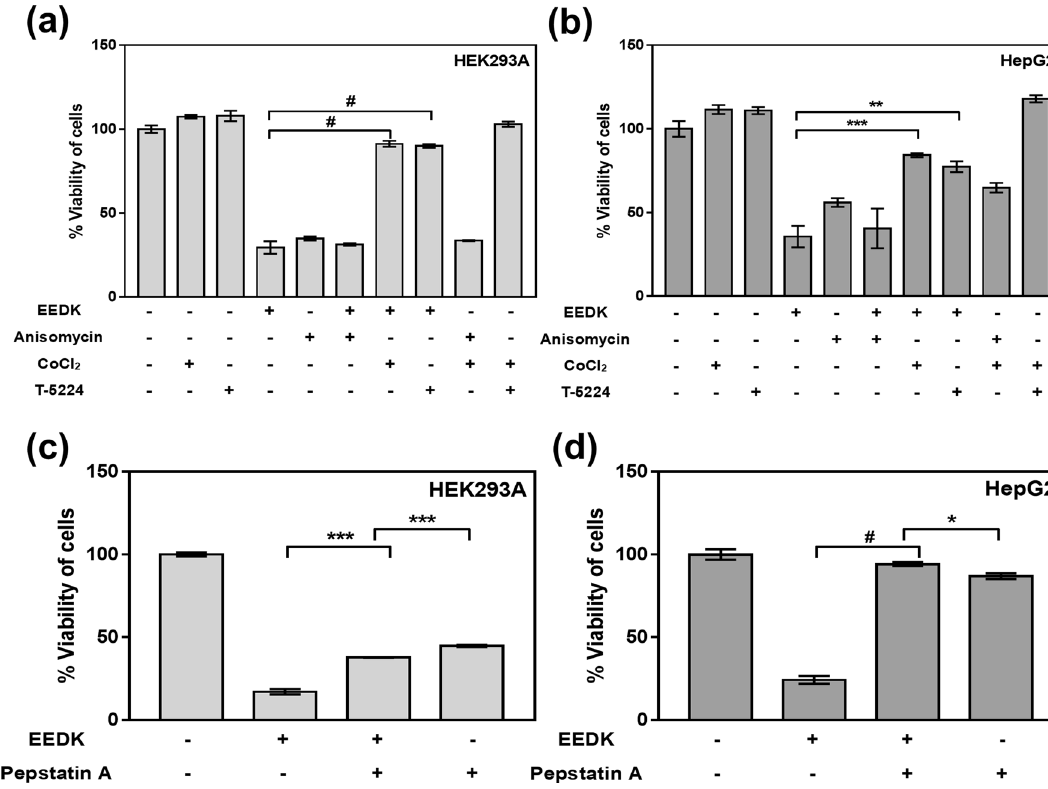
Figure 7. The effects of EEDK on cell death are dependent on JNK-AP-1/p53 activity. ( a , b ) Viability of ( a ) HEK293A and ( b ) HepG2 cells treated with or without the control (0.5% (v/v) DMSO), EEDK (100 μg/mL), anisomycin (JNK activator, 4 μM), CoCl 2 (hypoxia mimicking agent, 150 μM), and T-5224 (AP-1 inhibitor, 10 μM) for 24 h, as measured using the viability assay (n = 4). ( c , d ) Viability of (c) HEK293A and (d) HepG2 cells treated with or without the control (0.5% (v/v) DMSO), EEDK (100 μg/mL), and pepstatin A (aspartic proteases inhibitor, 1 μM) for 24 h, as measured using the viability assay (n = 3). Anisomycin was used as a positive control. Pepstatin A is a known suppressor of p53 and TNF-α induced apoptosis. The bar graphs present the mean values of cell viability, with error bars indicating the S.E.M (* P < 0.05, ** P < 0.01, *** P < 0.001 and # P < 0.0001, Student’s t